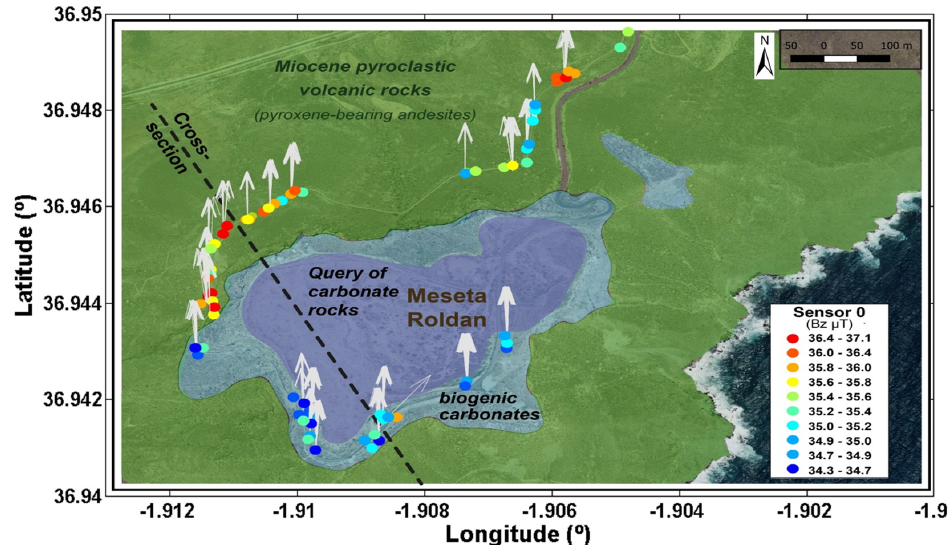
Figure 16. Magnetic field intensity and direction of Mesa Roldán in Cabo de Gata registered by the on-ground equipment. on-ground